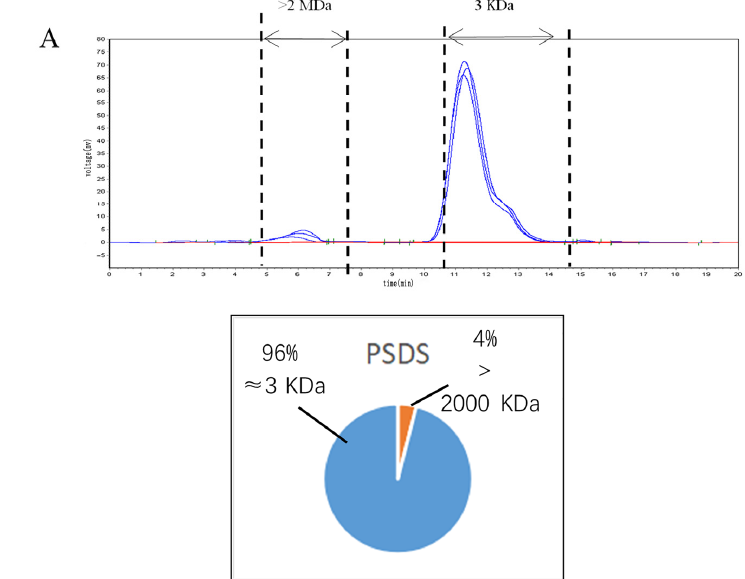
Figure 1. HPLC-RID chromatogram of purified polysaccharide from PSDS ( A ); Molecular weight peak area of each fraction of CR polysaccharides accounting for the percentage of total peak area ( B ).